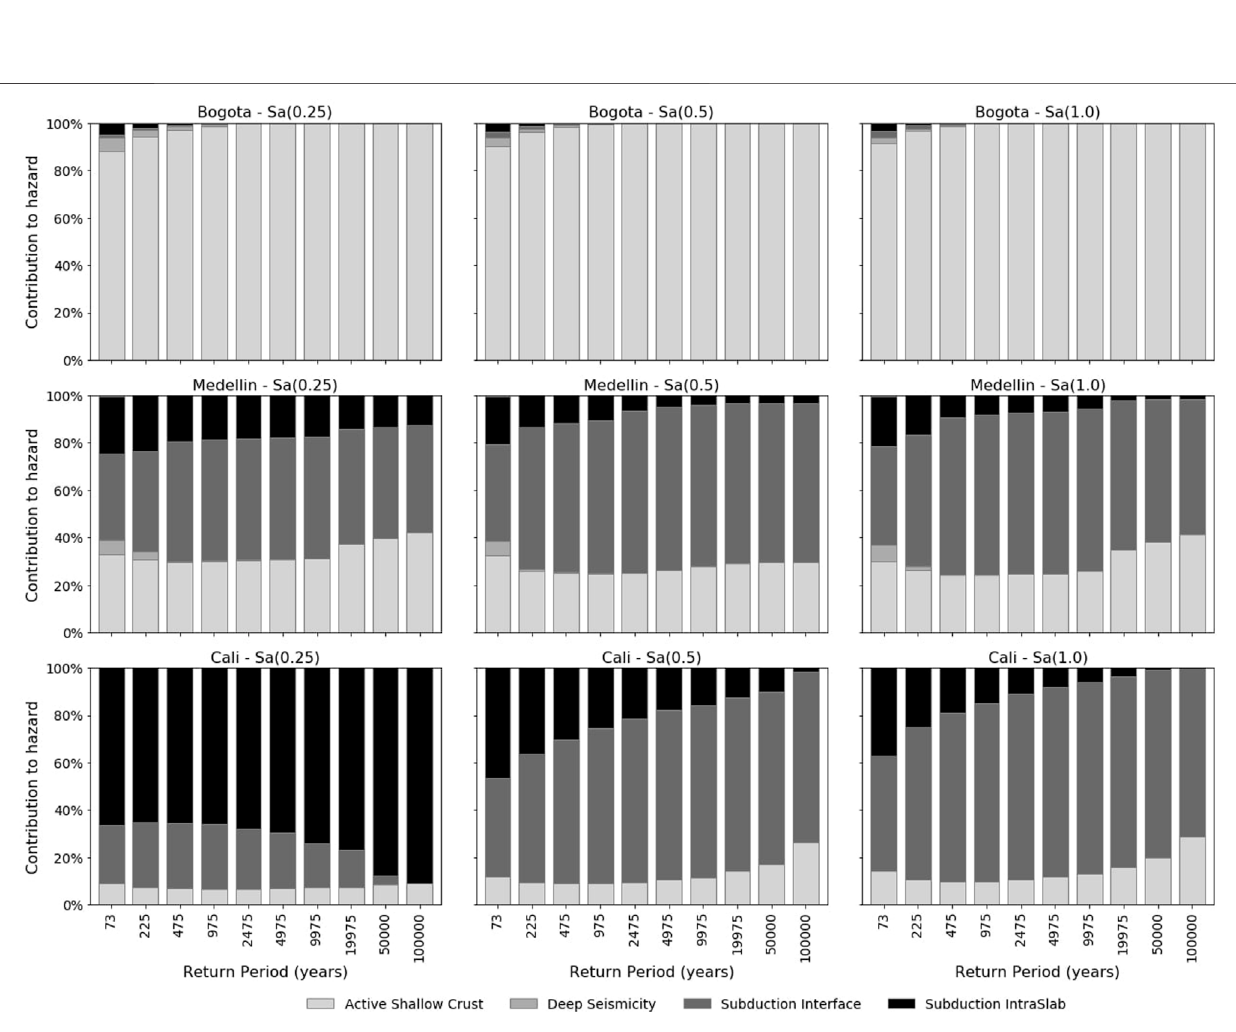
Frontiers in Earth Science |